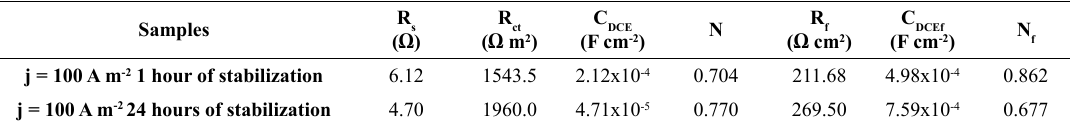
and C values obtained from the simulation of the EIS data of the Cu-Sn coating produced using j = 100 A m -2 , after 1h Table 4. R ct DCE and 24h of immersion in NaCl 0.5 mol L -1